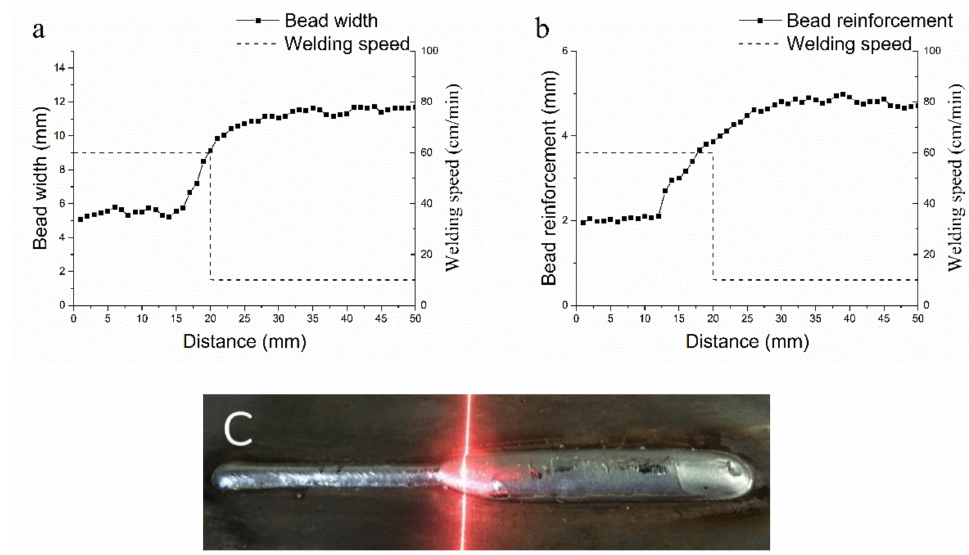
Figure 5. Results of transient response test (welding speed steps from 60 cm/min to 10 cm/min.). ( a ): bead width value; ( b ): bead reinforcement value; and, ( c ): actual bead.